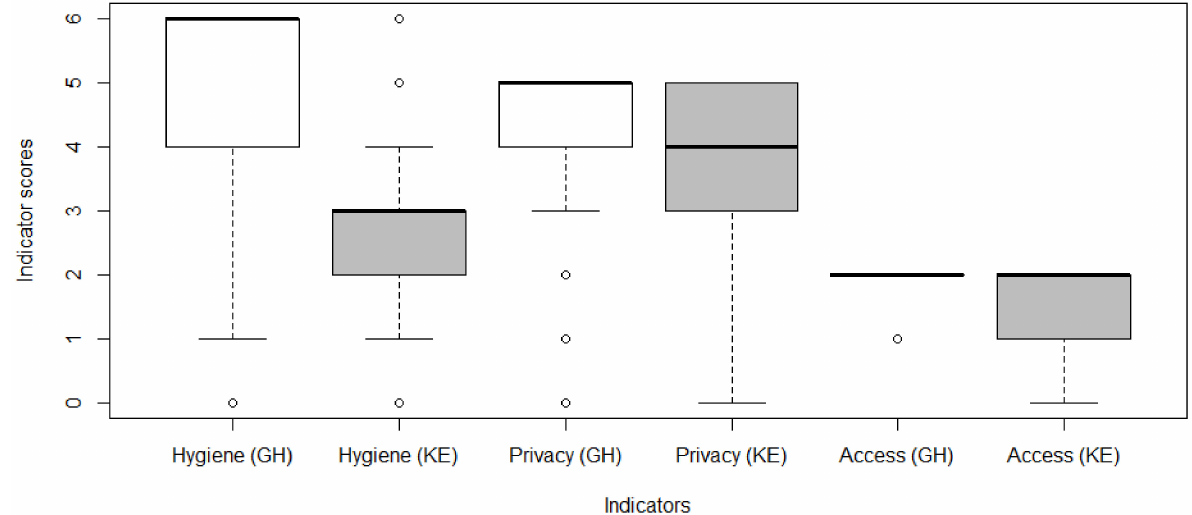
Figure 1. Comparison of indicators of sanitation quality for Ghana and